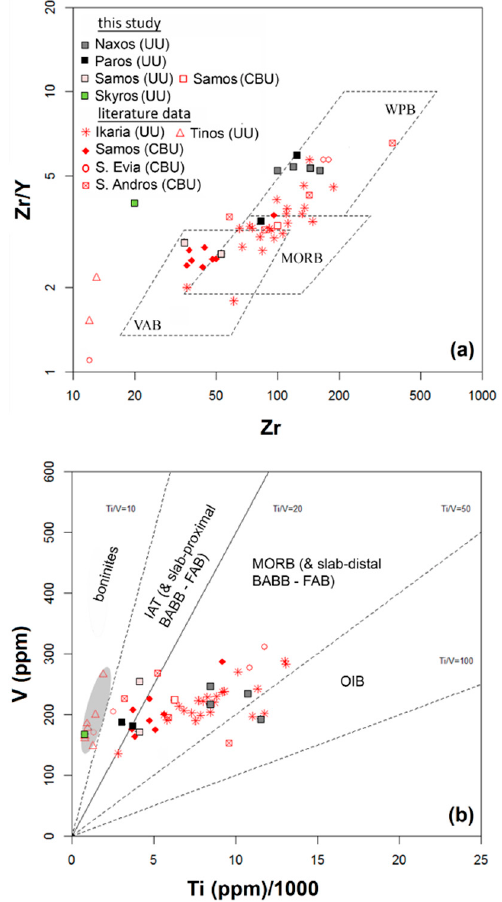
Figure 12. Tectonomagmatic discrimination of metabasites (gabbros, basaltic andesites, and dolerites) of Aegean ophiolites: ( a ) Zr vs. Zr/Y [60], and ( b ) Ti/V discriminant plot of [56] modified in field names after [50]. Abbreviations in ( a ): VAB = Volcanic Arc Basalt, WPB = Within-Plate Basalt and MORB = Mid-Ocean Ridge Basalt; in ( b ): OIB = Ocean Island Basalt, IAT = Island Arc Tholeiite; FAB = Fore-Arc Basalt, BABB = Back-Arc Basin Basalts. Symbols: black = this study, red = published data (data from Samos, Tinos Upper Unit, S. Evia: [15]; Andros: [28]; Ikaria: [10]). True MORB samples are only a few, the majority of Cycladic metabasites plot in the transitional VAB/MORB field. From the WPB group, only Naxos metabasalts, and two amphibolite samples from Ikaria (Faros) [10], can be geochemically classified as alkali basalt: Nb/Y > 1 and high P, Ba, Sr and Ce N /Yb N , higher than E-MORB (i.e., >2) these geochemical features rather resemble